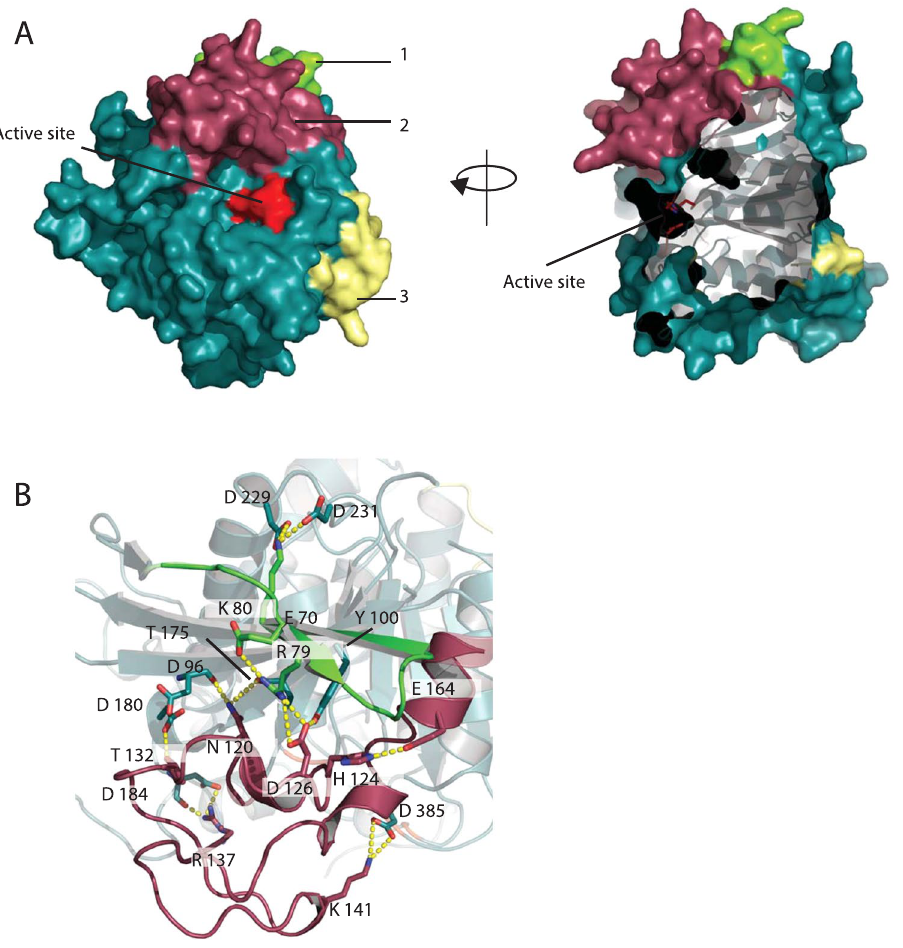
Figure 2. Surface view ( A ) of MZ0003 with the loop regions 1-3 coloured green, dark pink and yellow. The protein core is coloured teal, and the catalytic triad is bright red. ( B ) Salt bridge and hydrogen bond network between regions 1 and 2, contributing to the novel